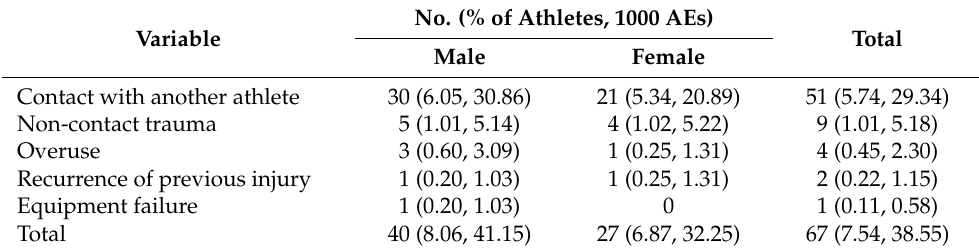
Table 4. Mechanisms of the injuries that occurred at the 2018 WTJC.